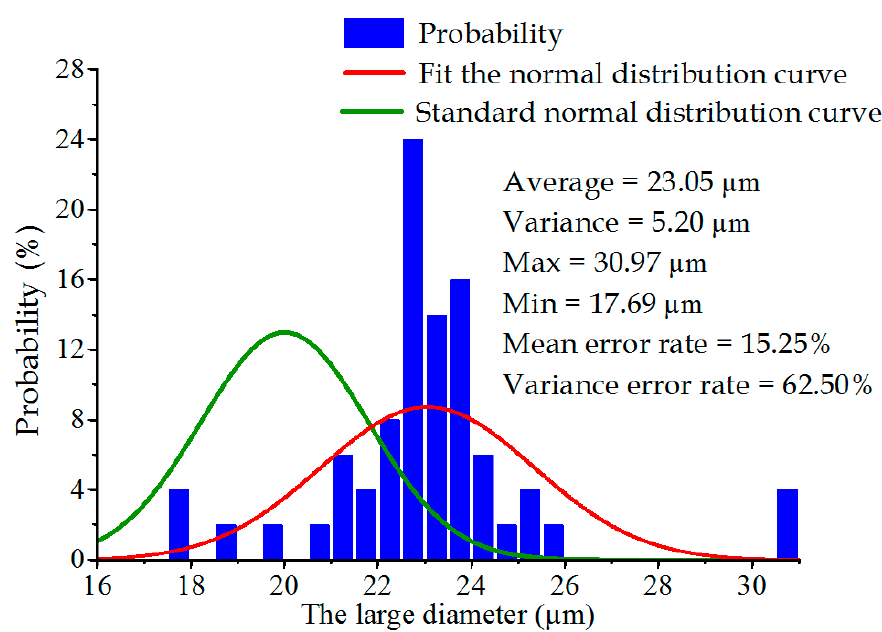
Figure 7. Distribution of the large diameter.